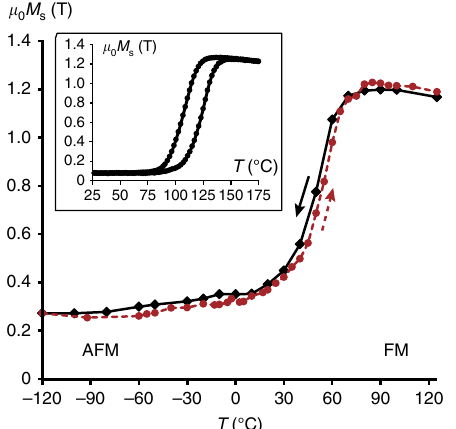
Figure 3 | Local magnetization versus temperature loop. x component of the magnetization as a function of temperature for a complete temperature cycle. The values are obtained at the remnant state from the slope of the magnetic phase shift averaged on the field of view detailed in Fig. 2. The cooling and heating series correspond to the black and red dashed lines respectively. In insert, the M ( T ) loop measured by vibrating sample magnetometry on the whole FeRh sample from which the thin lamella has been extracted for electron holography experiments. This loop has been acquired with a 2kOe field applied along the [110] axis of the FeRh